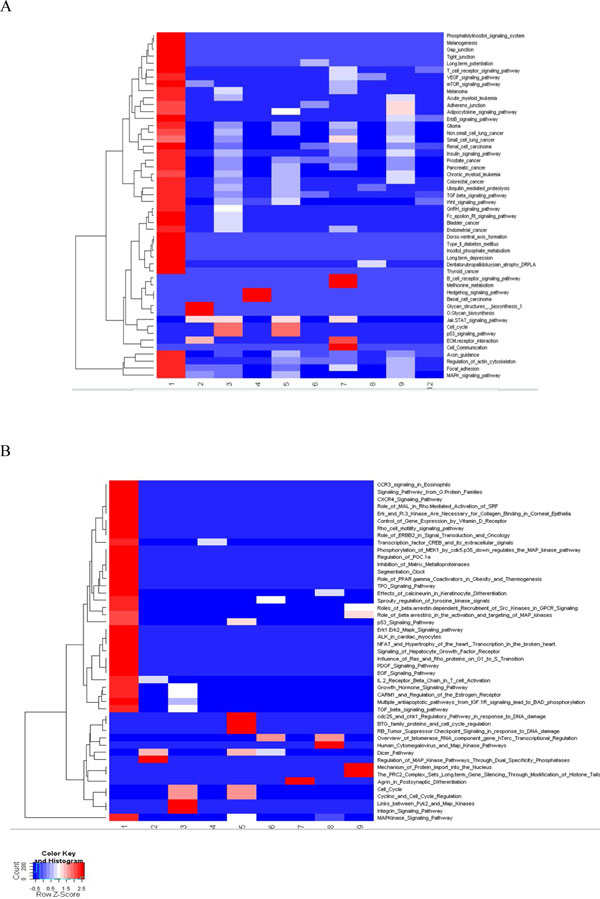
Heatmap of over-represented biological pathways of target genes of CMM. Color gradient represents statistical significance as the -log10 (p-value) in the hypergeometric test for enrichment analysis using (A) KEGG pathway and (B) BioCarta pathway. Red indicates significant associations while blue indicates insignificant associations.